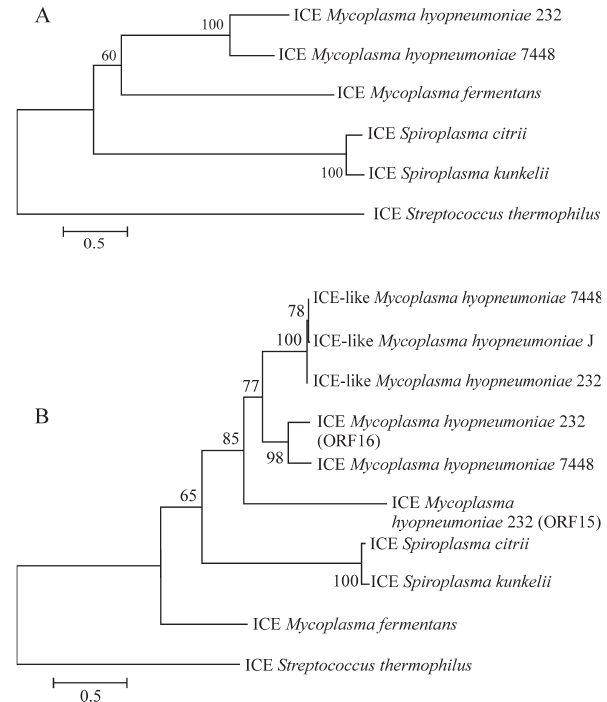
Figure 4 - Phylogenetic analysis of the ICE elements and TraE genes A: Neighbor-Joining tree calculated using the JTT distance of three concate- nated ortologous CDS between the six analyzed elements.(The parsimony tree had the same topology of the Neighbor-joining analysis and was omit- ted from the figure). B: Neighbor-Joining tree calculated using the JTT distance of 10 TraE genes found in the elements ICEH-Like MH232,